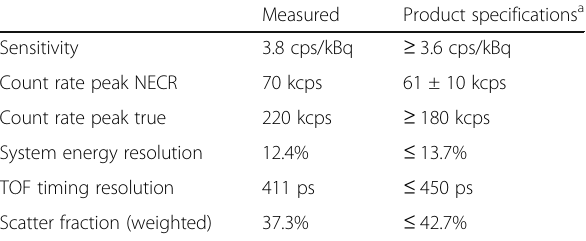
Table 4 Sensitivity and count rates of the Celesteion system